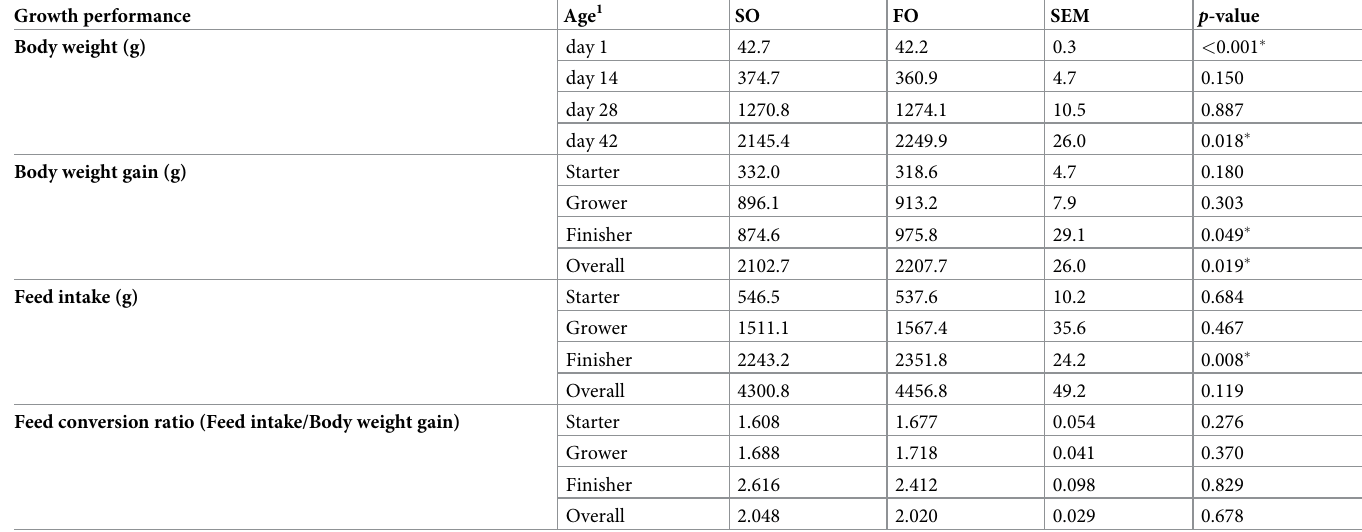
Table 3. Growth performance.